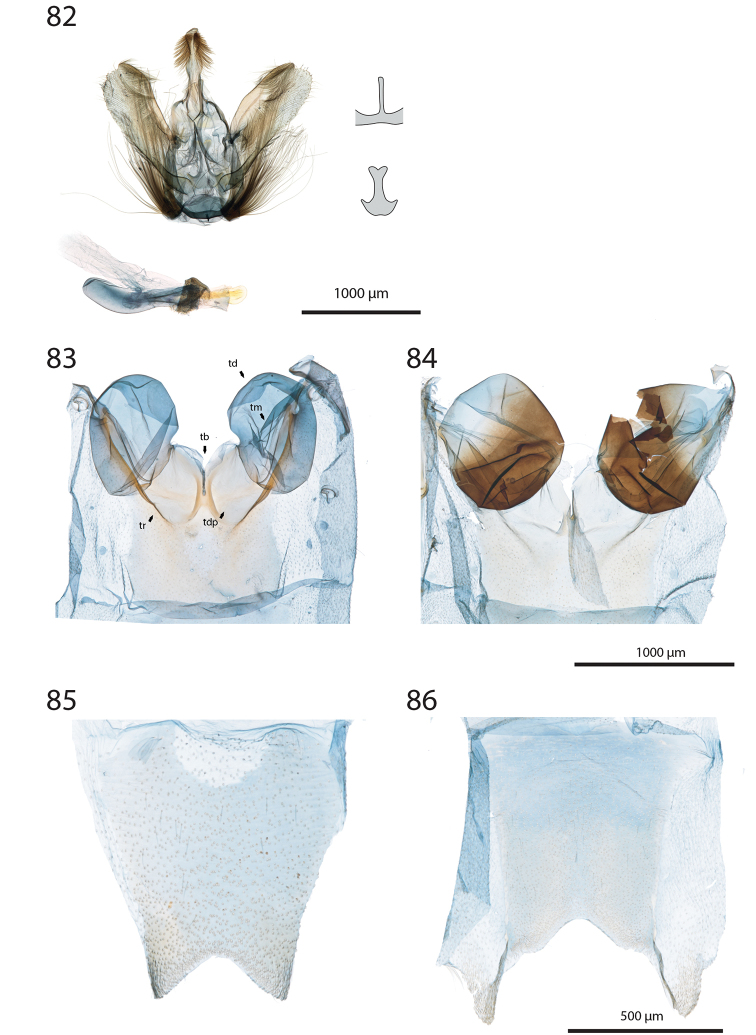
Male genitalia and abdomen features of Hoploscopa. 82Hoploscopa
jubata sp. nov., paratype, TL542 ♂ 83 Tympanal organs of Hoploscopa
sumatrensis sp. nov., paratype, TL538 ♂ 84 Male tympanal organs of Hoploscopa
metacrossa, TL472 ♂ 85 Sternite VIII of Hoploscopa
sp. near
isarogensis, TL626 ♂ 86 Sternite VIII of Hoploscopa
metacrossa, TL443 ♂. Abbreviations: tb (tympanic bridge), td (tympanic drum), tdp (tympanic depression), tm (tympanum), tr (transverse ridge).